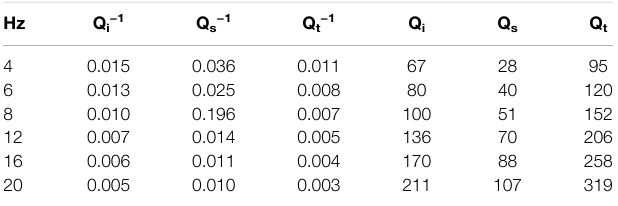
TABLE1| AveragevaluesofQ i − 1 ,Q s − 1 ,Q t − 1 ,Q i, Q s ,andQ t foralapsetimeof20 s for the Aeolian